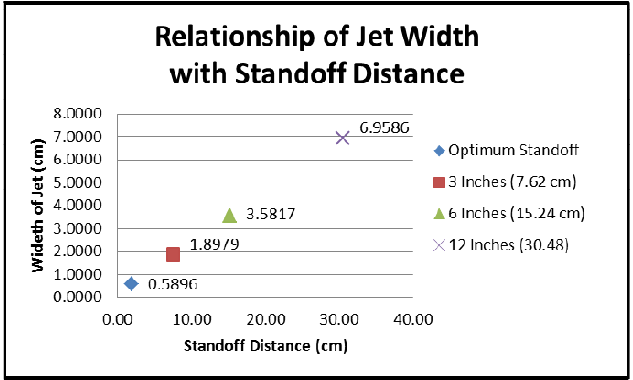
Figure 9. Jet width at different standoff distance.